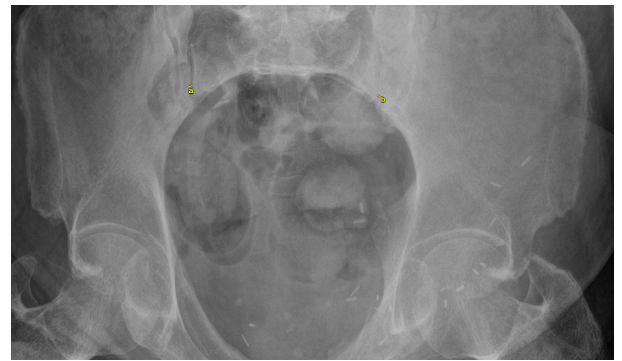
Figure 2. Inlet radiograph of the pelvis, with the yellow lines demonstrating the measurements for sacroiliac (SI) joint diastasis. The measurements were 4.0mm for the right SI joint (a) and 3.7mm for the left SI joint (b)